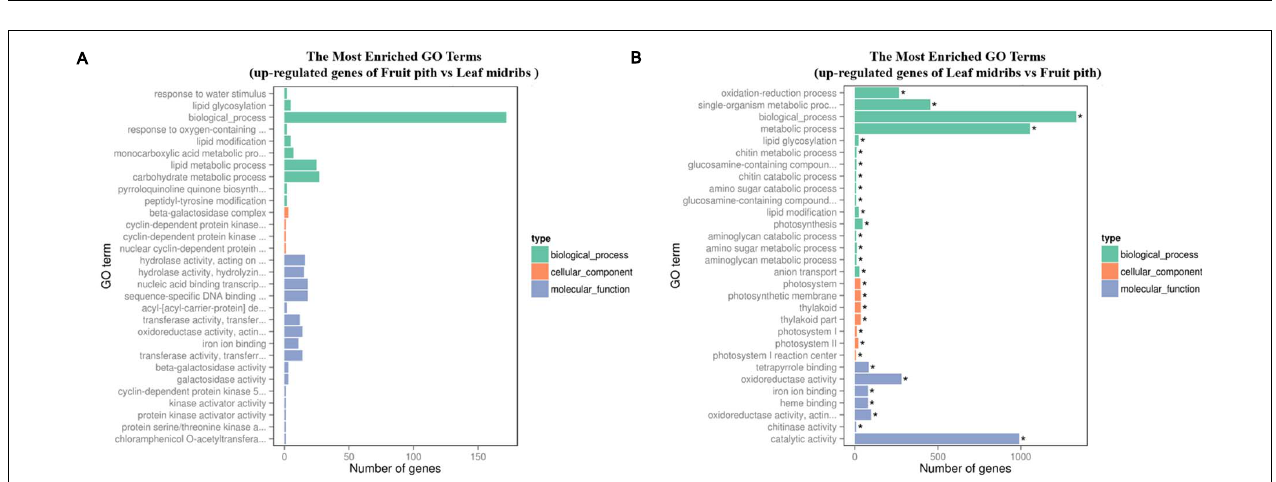
FIGURE 5 | GO term enrichment analyses of the up-regulated genes in “ Candidatus Liberibacter asiaticus” (CLas)–infected fruit pith (A) and CLas-infected leaf midribs (B) . The vertical coordinates represent enriched GO terms, and the horizontal coordinates represent the numbers of up-regulated genes in these GO terms. Green columns: biological process GO terms; purple columns: cellular component GO terms; orange columns: molecular function GO terms. *Significantly enriched GO term.